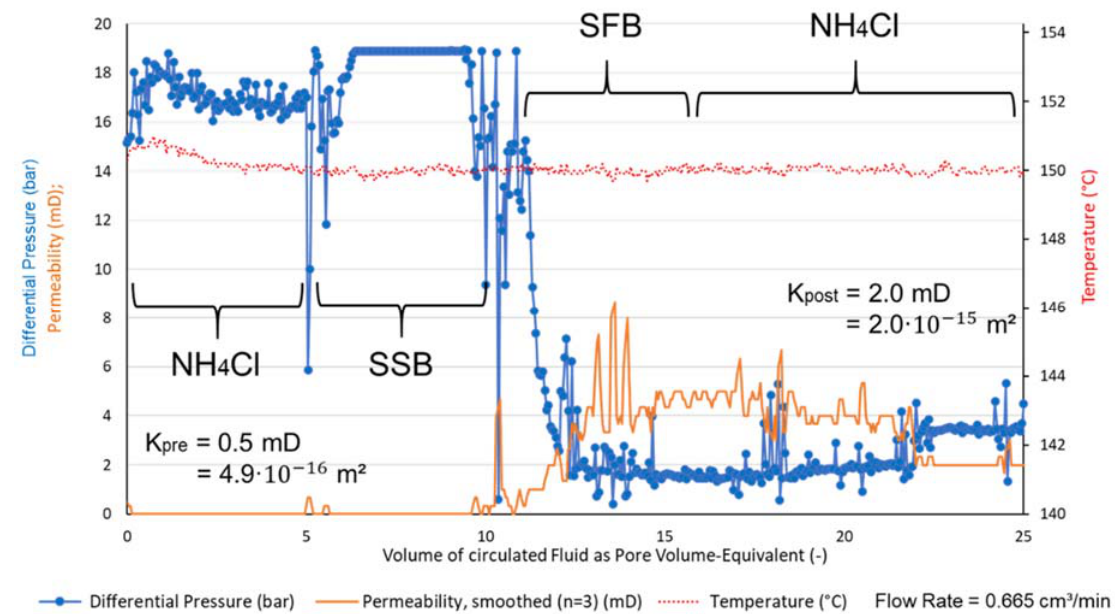
Figure 6. Pore volume—differential pressure diagram showing the development of the CFT on sample 6, applied flow rate: 0.665 mL/min; modified after [44].